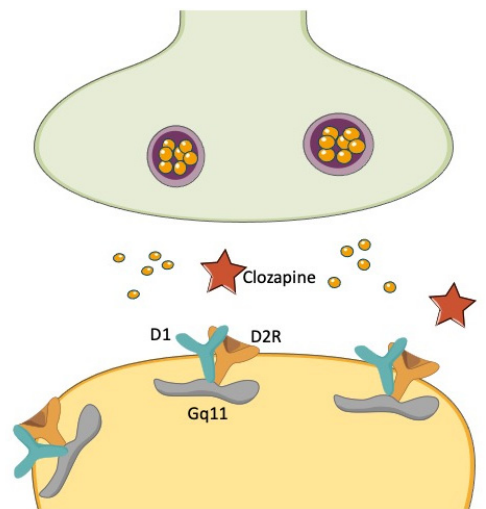
Figure 4. D1R/D2R heterodimerization and the clozapine conundrum. The heterodimerization of D1Rs and D2Rs has been described to yield a powerful stimulation of unique Gq11-mediated signaling, which is distinct from the signaling pathways activated by D1Rs and D2Rs, respectively, when stimulated separately. The effectiveness of clozapine in treatment resistant schizophrenia has been conceptualized to depend on the simultaneous occupancy of D1Rs and D2Rs and the subsequent inhibition of their effects on this unique transduction pathway.